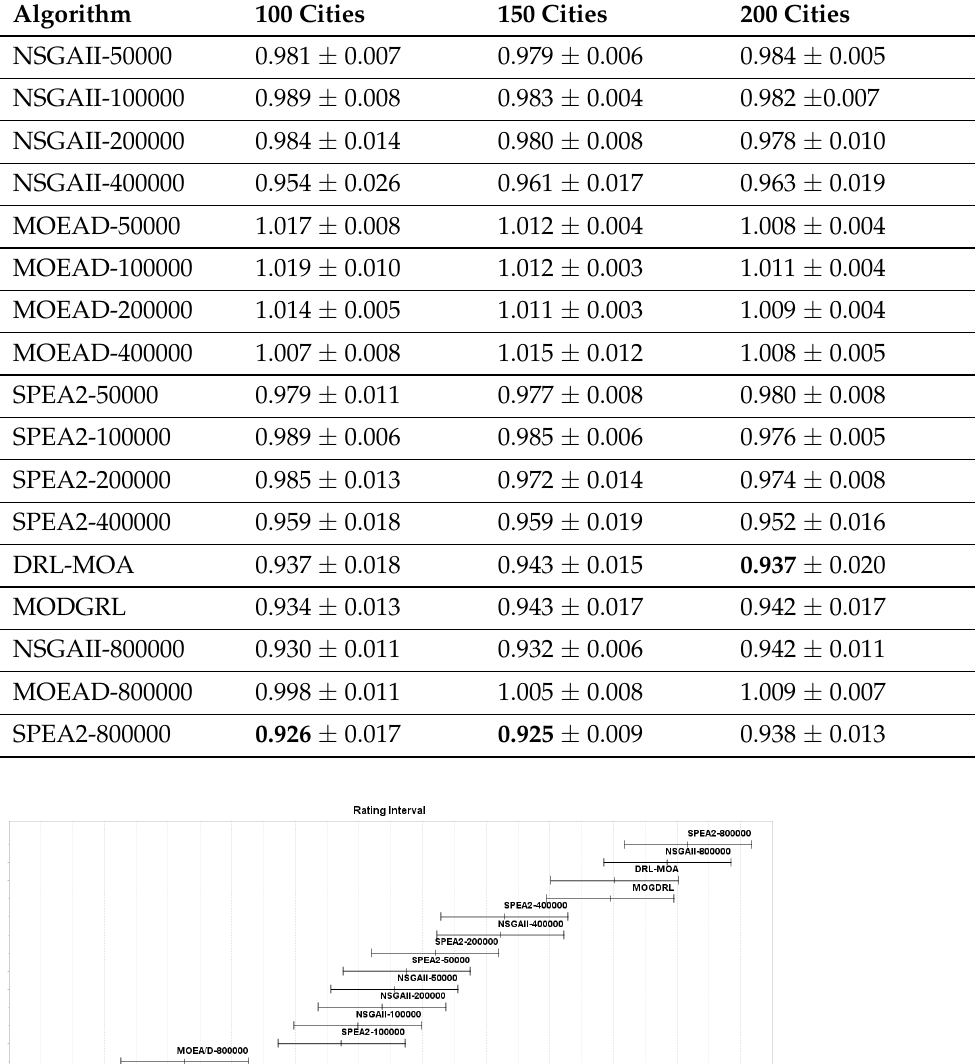
Table A2. Comparison of Spread values. The minimum values are the best. The bold values are the best ones among all algorithms.